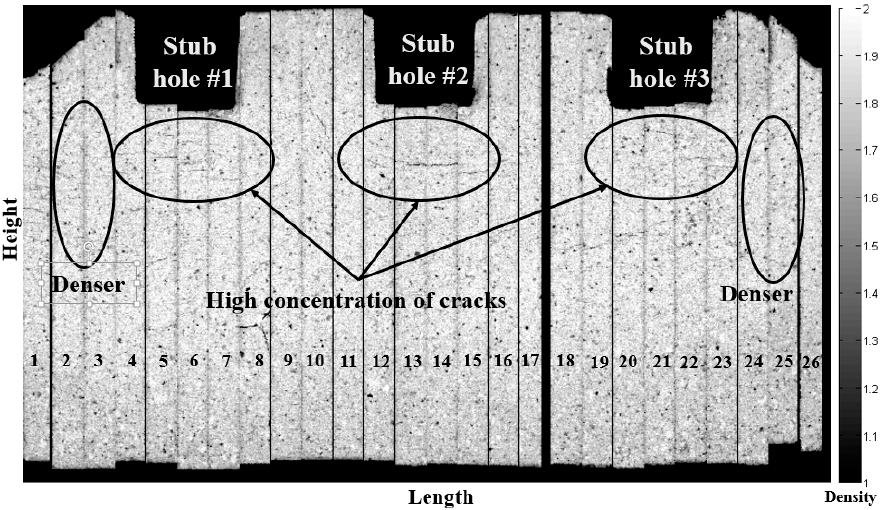
Figure 8. X ‐ ray images showing a transversal section of the sliced anode.